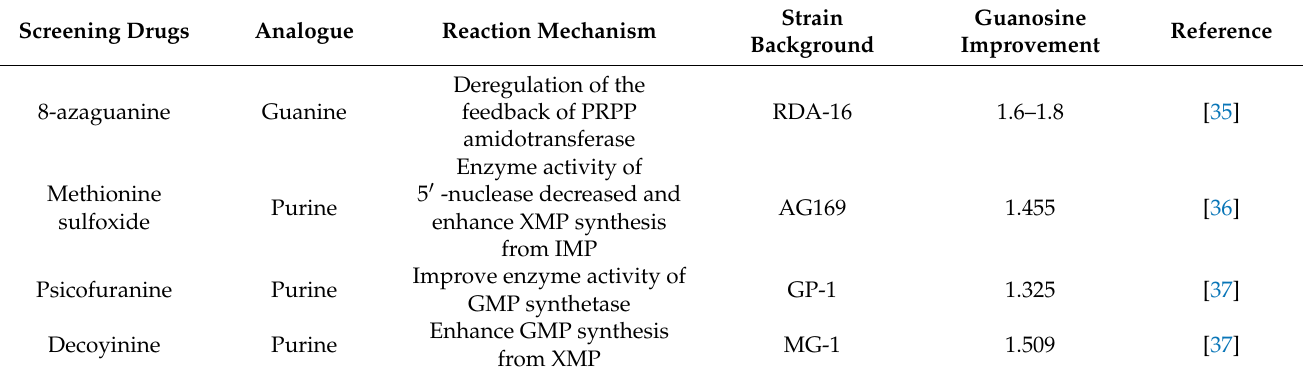
Table 2. Mechanism and effect of reagents used for screening riboflavin-overproducing